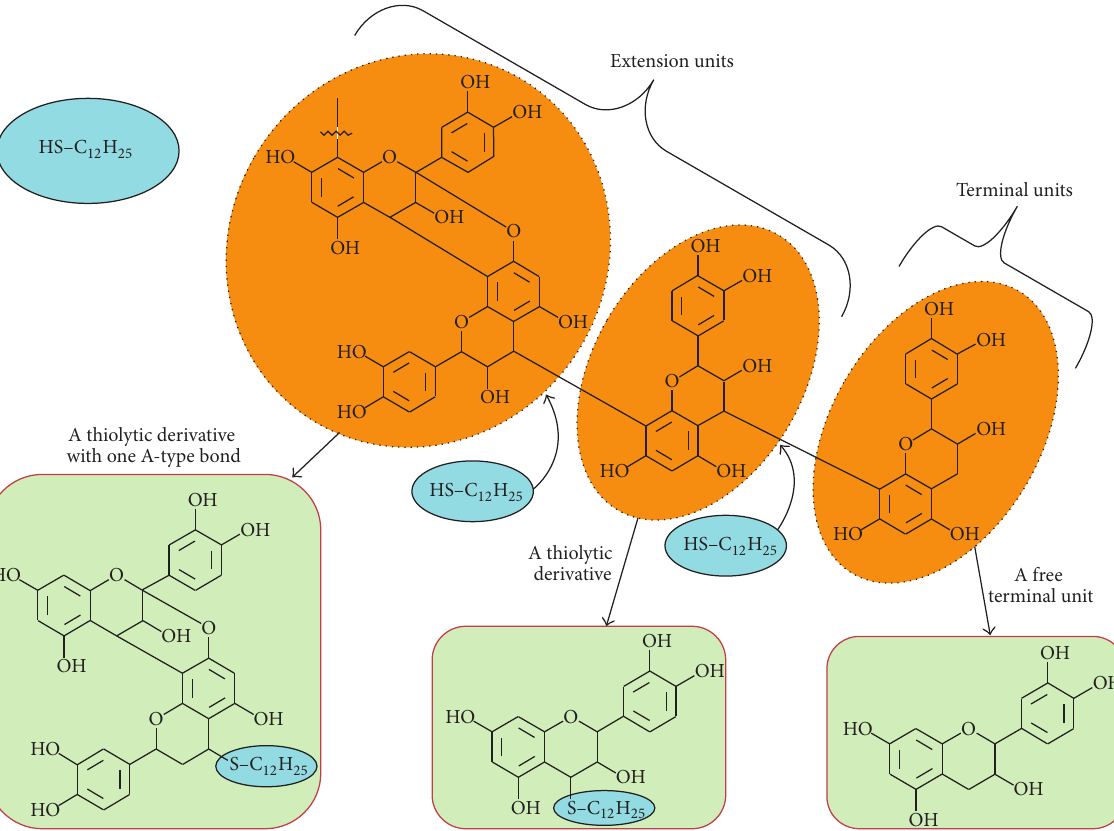
F 1: iolytic cleavage of highly polymeric proanthocyanidins having a series of heteropoly�avan-3-ols, (�)-catechin�( with doubly linked A-type inter�avan linkages and single B-type